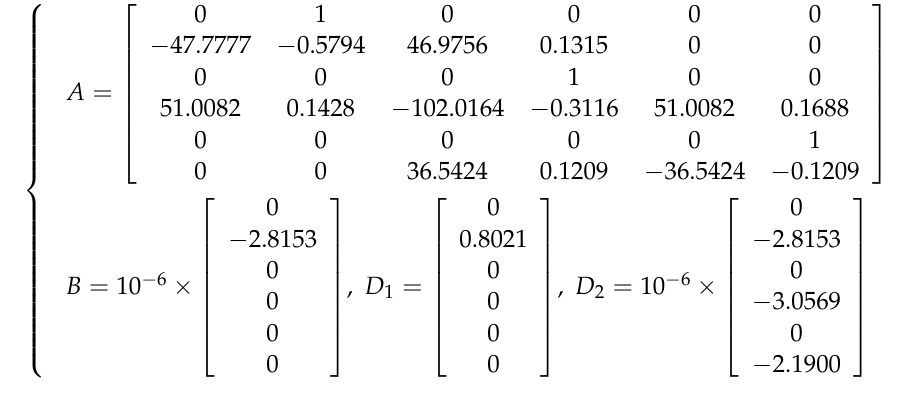
Table 1. Parameters of riser system.